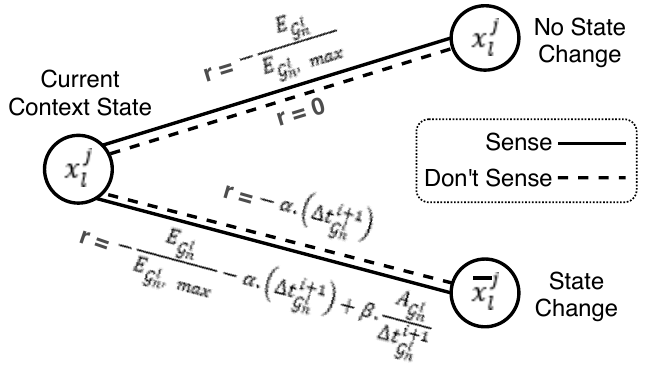
Figure 8. State transition diagram showing the instantaneous reward values for the different condi- tions of “Sense” and “Do not Sense” sensor triggering decision, depending on whether the state has changed or